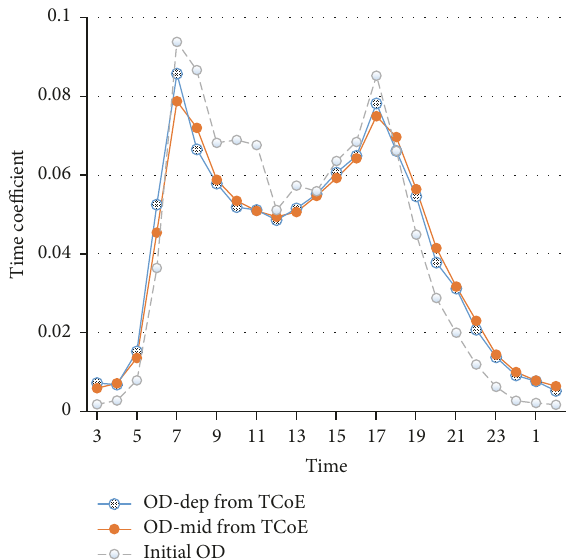
Figure 9: Comparison of hourly variation